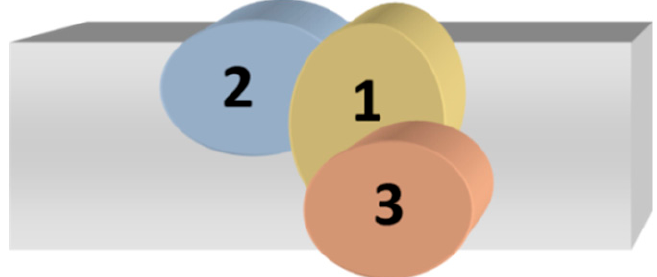
Figure 4. Welding order 3—lower stitch, 1, 2—upper stitch.